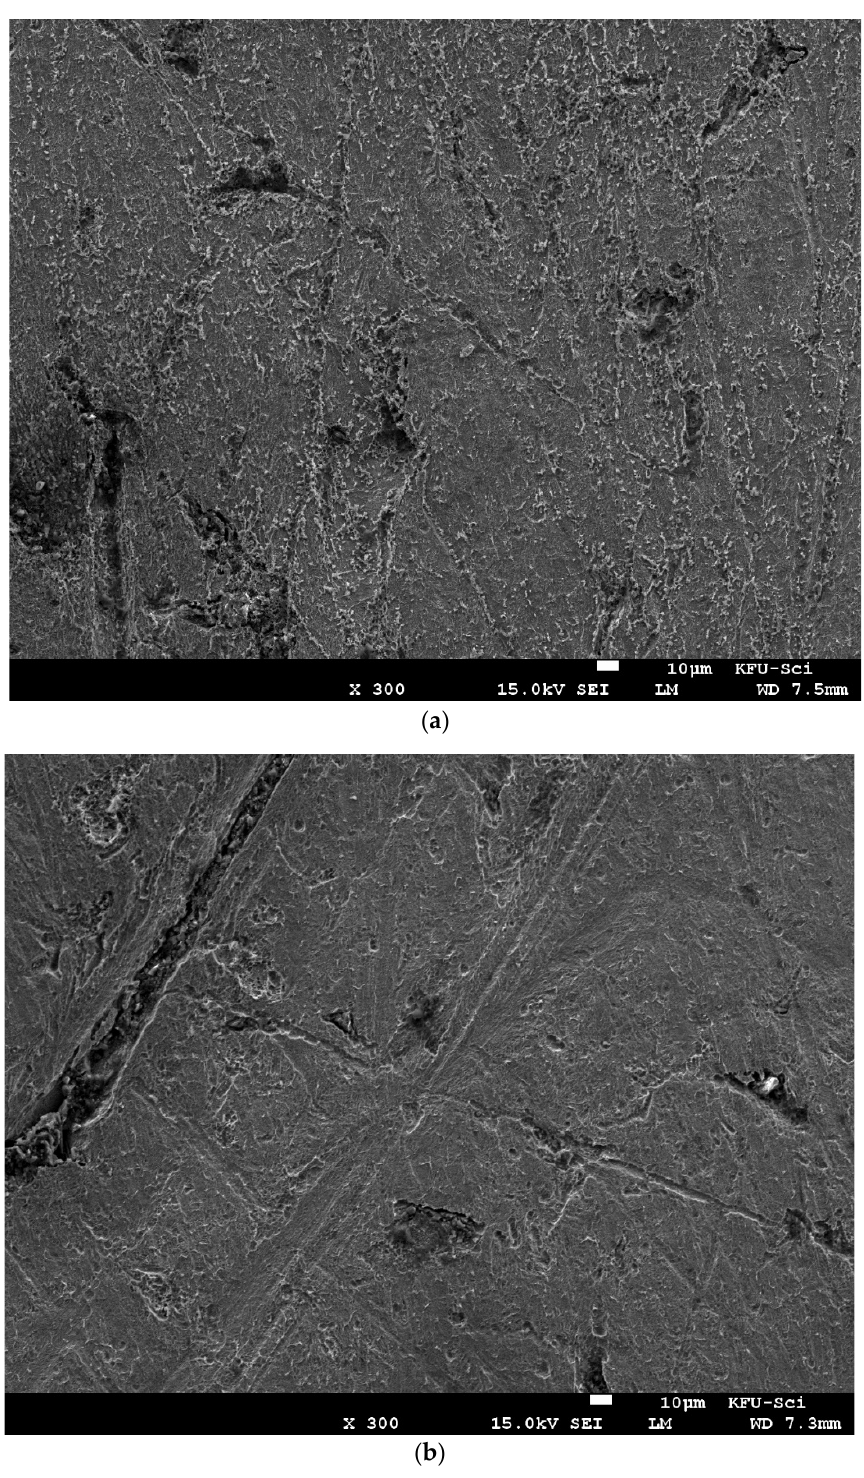
Figure 13. SEM images of C-steel immersed for 3 h in ( a ) free 0.25 M H 2 SO 4 and ( b ) 0.25M H 2 SO 4 containing 300 ppm of Harmal leaf extract (HLE).